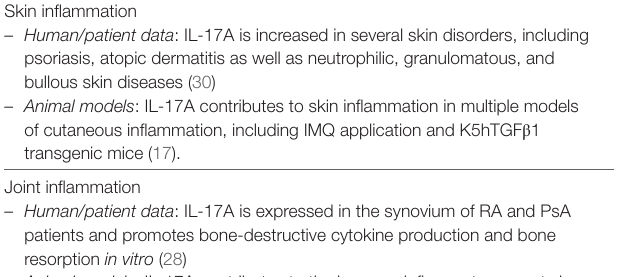
TABLe 1 | Overview of the role exerted by IL-17A in inflammation. Skin inflammation – Human/patient data : IL-17A is increased in several skin disorders, including psoriasis, atopic dermatitis as well as neutrophilic, granulomatous, and bullous skin diseases (30) – Animal models : IL-17A contributes to skin inflammation in multiple models of cutaneous inflammation, including IMQ application and K5hTGF β 1 transgenic mice (17).